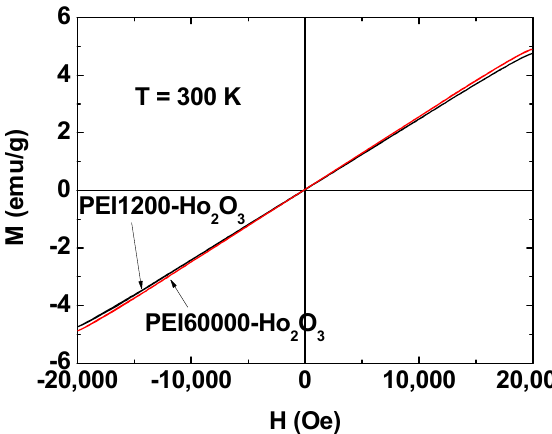
Figure 7. Mass-corrected M–H curves of the PEI1200- and PEI60000-coated ultrasmall Ho 2 O 3 nanoparticles at 300 K obtained using the net masses of Ho 2 O 3 nanoparticles without PEI, which were estimated from the TGA curves. Table 3. Magnetic properties and water proton spin relaxivities.